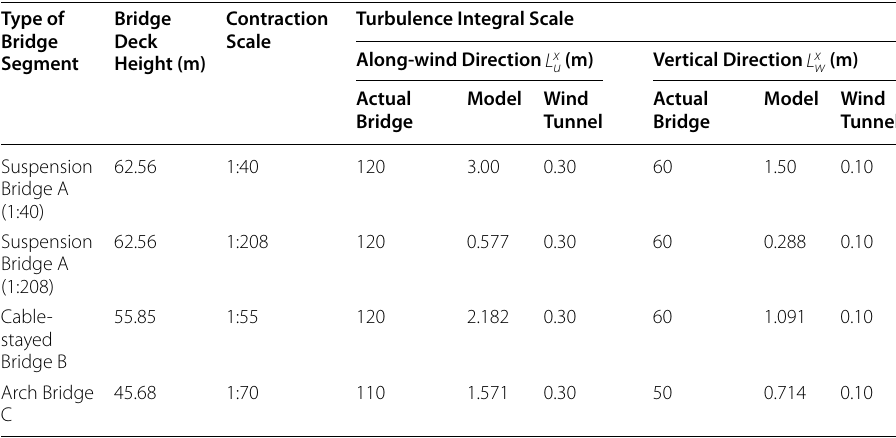
Table 5 Comparison of different turbulence integral